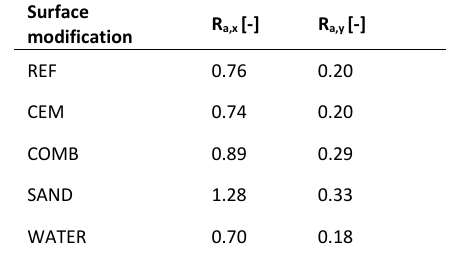
Table 3. Surface roughness measurements.